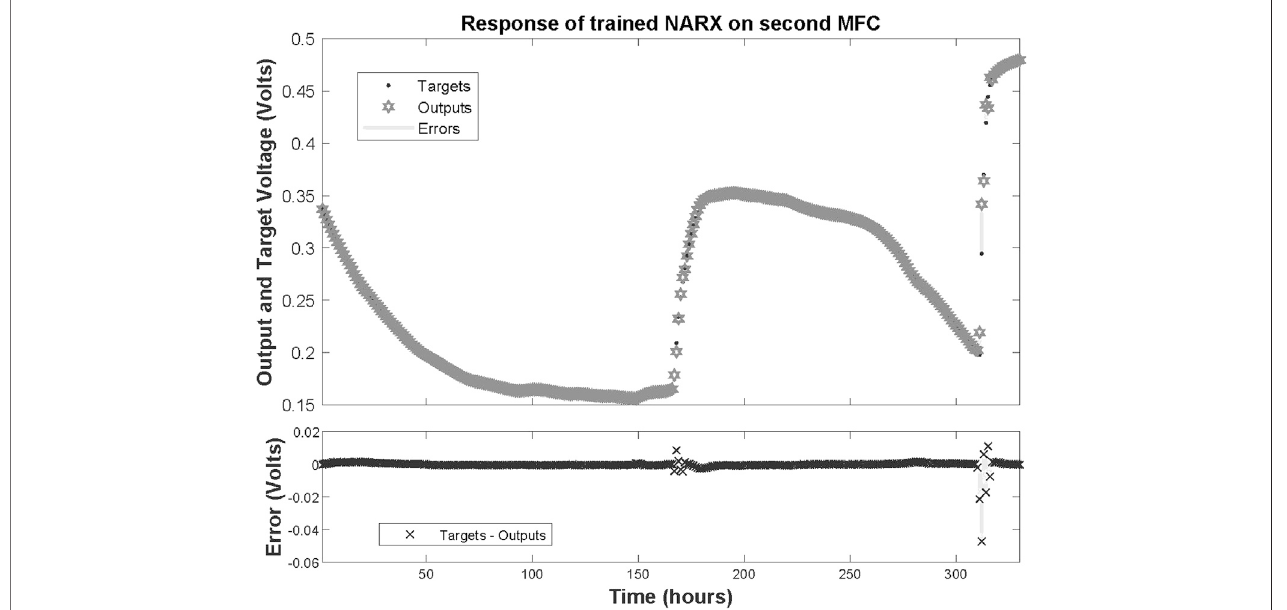
FIGURE 7 | Response of trained NARX on dataset time-series of second MFC and associated errors.